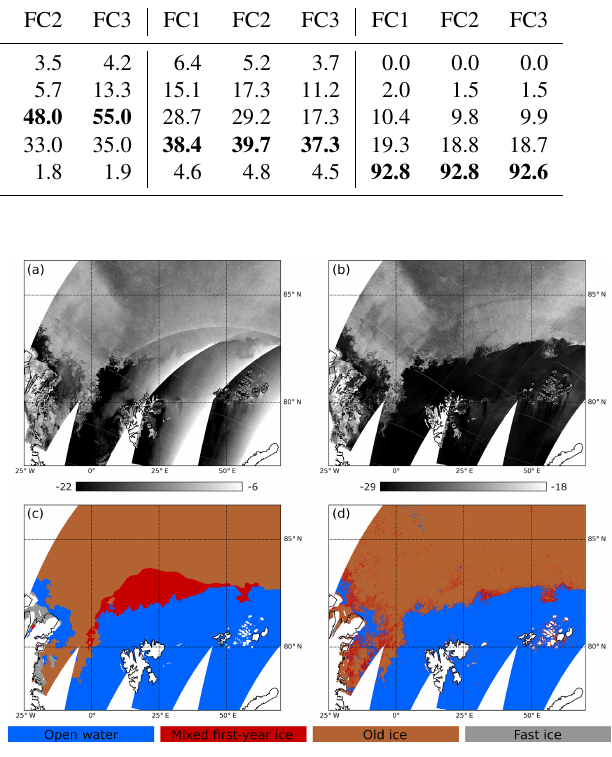
Figure 9. The 1d mosaics of Sentinel-1A/1B images ( a : HH; b : HV) and the ice classification result (d) on 13 August 2018. The publication date of the reference weekly ice chart (c) is 16 Au- gust